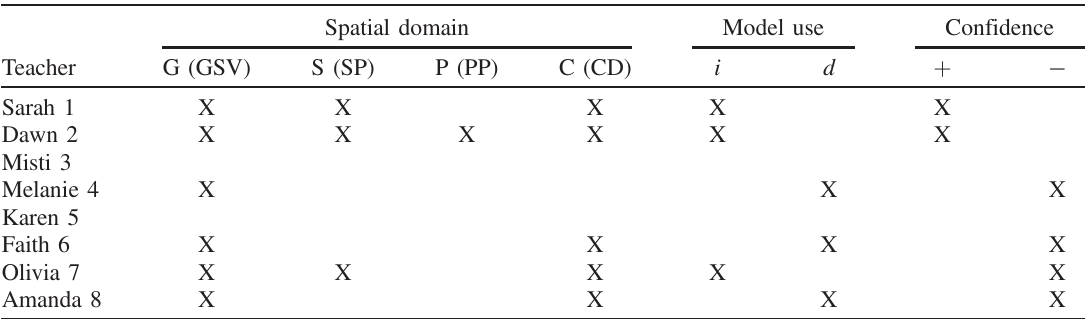
TABLE IV. Coded video analysis of spatial domain presence, model use, and confidence level by teacher. Note that neither Karen nor Misti enacted the lesson that was analyzed with the other teachers, resulting in no coding for enacted spatial-scientific confidence and